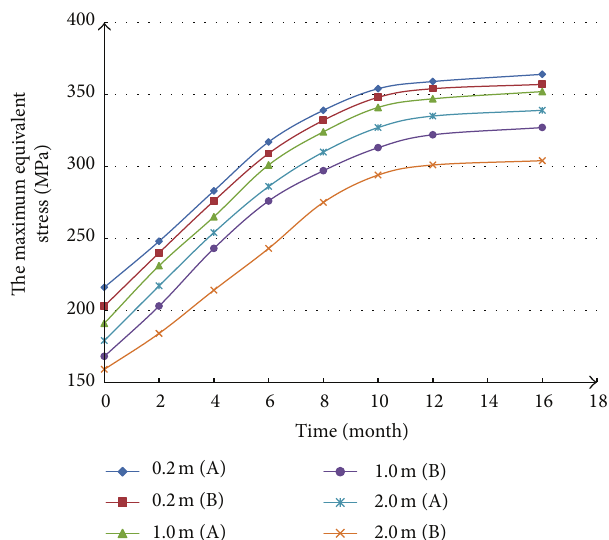
Figure 3: Relationship between the thickness of mudstone interbed and the casing equivalent stress. (A) The casing equivalent stress in themiddleof saltrock. (B)Thecasing equivalent stressinthemiddle of mudstone interbed.